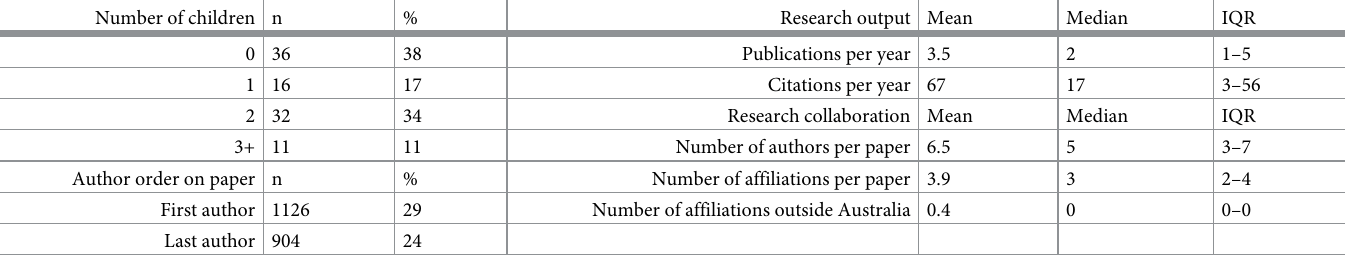
Table 1. Summary statistics on the women (n = 95) in terms of number of children, research output and research collaboration. The denominator for the per paper statistics is 3, 845 papers. IQR = inter-quartile range. Number of children n